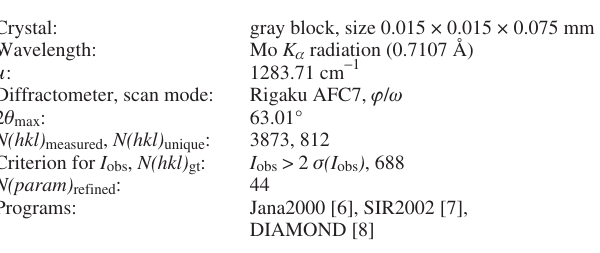
Table 1. Data collection and